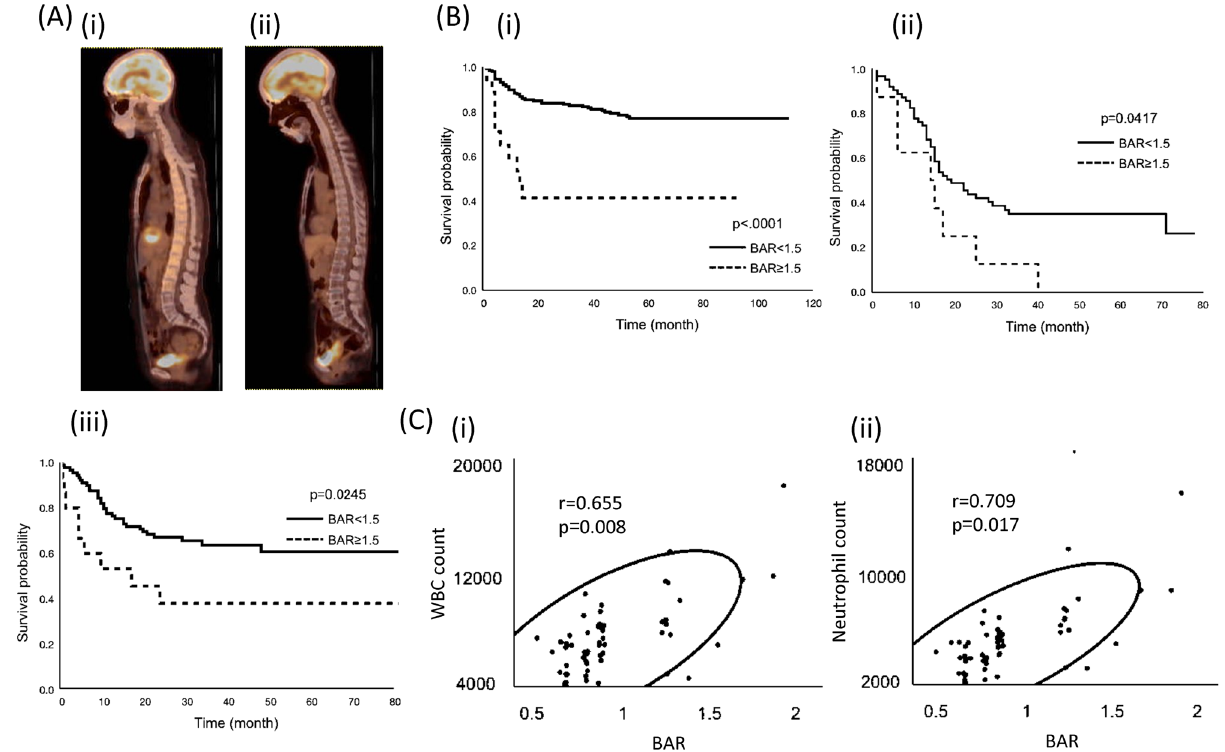
Figure 1. Clinical implications of BM FDG-uptake in patients with gynecologic cancer. ( A ) Fused sagittal 2-( 18 F) fluoro-2-deoxy-D-glucose as a tracer (FDG)-positron emission tomography/computed tomography (PET/CT) images. (i), patients with diffuse bone marrow FDG-uptake. (ii), patients with average bone marrow (BM) FDG-uptake. ( B ) Significance of BAR in patients with cervical cancer, patients with advanced stage ovarian cancer and patients with endometrial cancer. (i) Kaplan–Meier estimates of progression-free survival in patients with cervical cancer (higher-BAR group vs. lower-BAR group n = 231). (ii) Kaplan–Meier estimates of progression-free survival in patients with advanced stage ovarian cancer (higher-BAR group vs. lower- BAR group n = 87). (iii) Kaplan–Meier estimates of progression-free survival in patients with advanced stage endometrial cancer (higher-BAR group vs. lower-BAR group n = 113). ( C ) Correlation between BAR and neutrophils in patients with cervical cancer. The black circle; a density ellipse indicating correlation with a 95% confidence